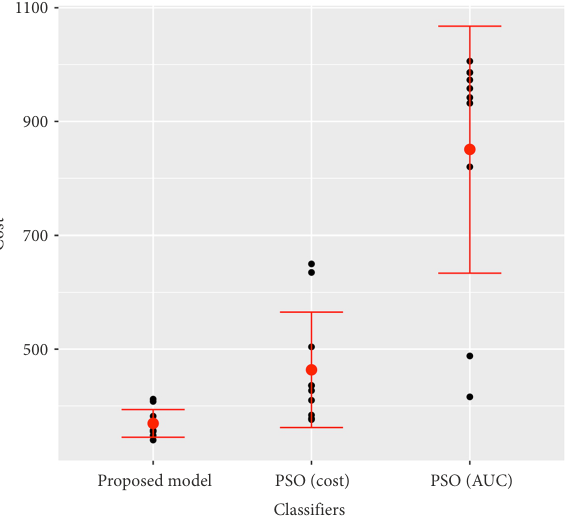
Figure 12. Total cost boxplot